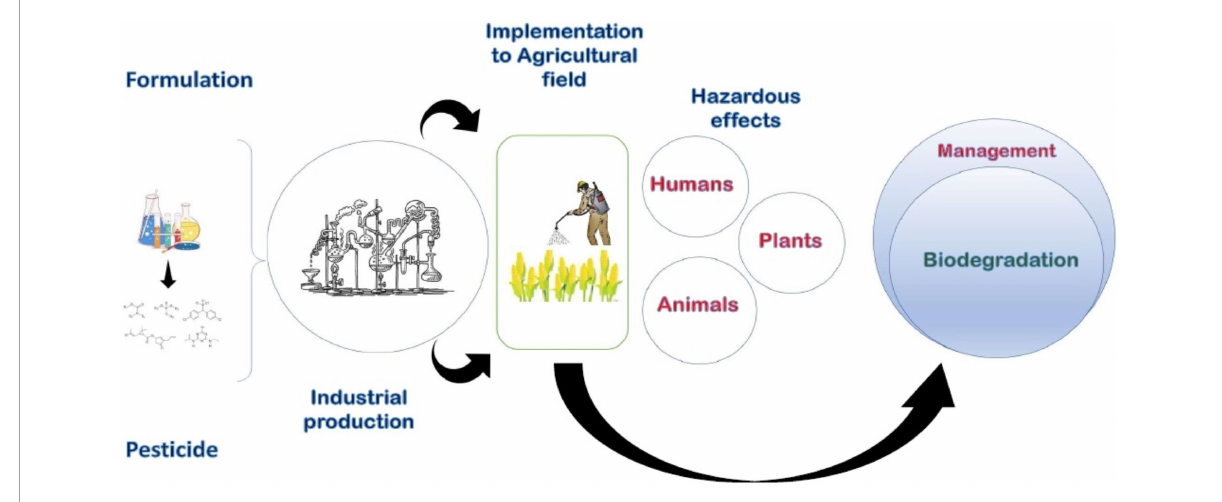
FIGURE2 Thematic diagram of the synthesis, production, uses, effects, and eco-friendly management of pesticides.